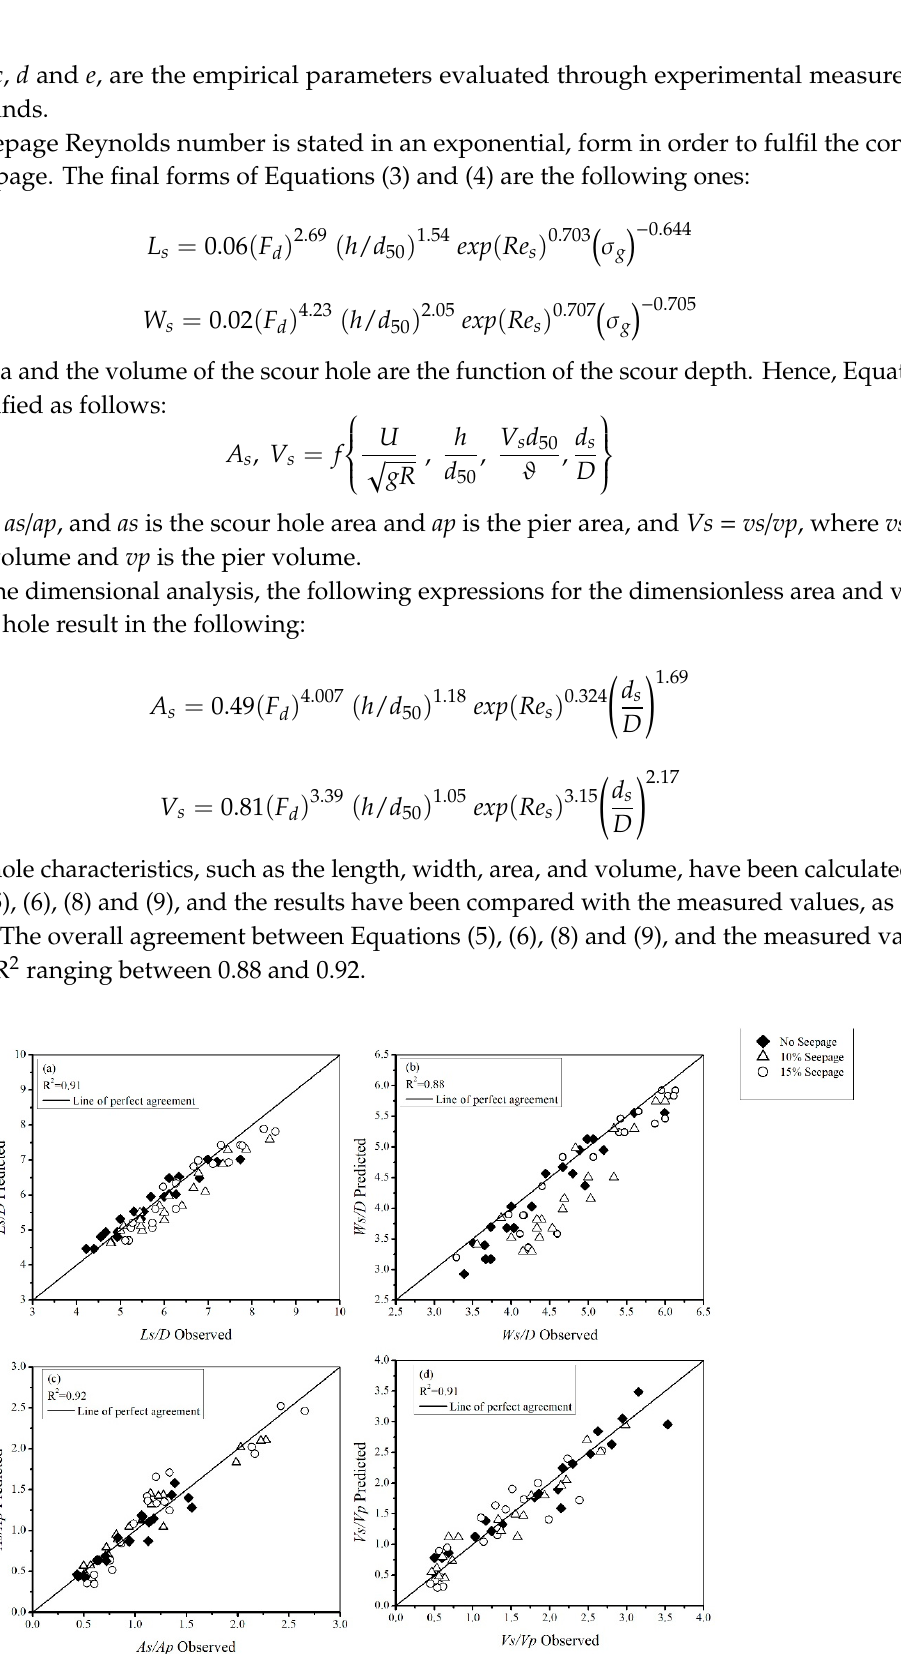
Figure 8. Comparison between the predicted and observed values of the dimensionless ( a ) scour length (Equation (5)), ( b ) scour width (Equation (6)), ( c ) scour area (Equation (8)), and ( d ) scour volume (Equation (9)).